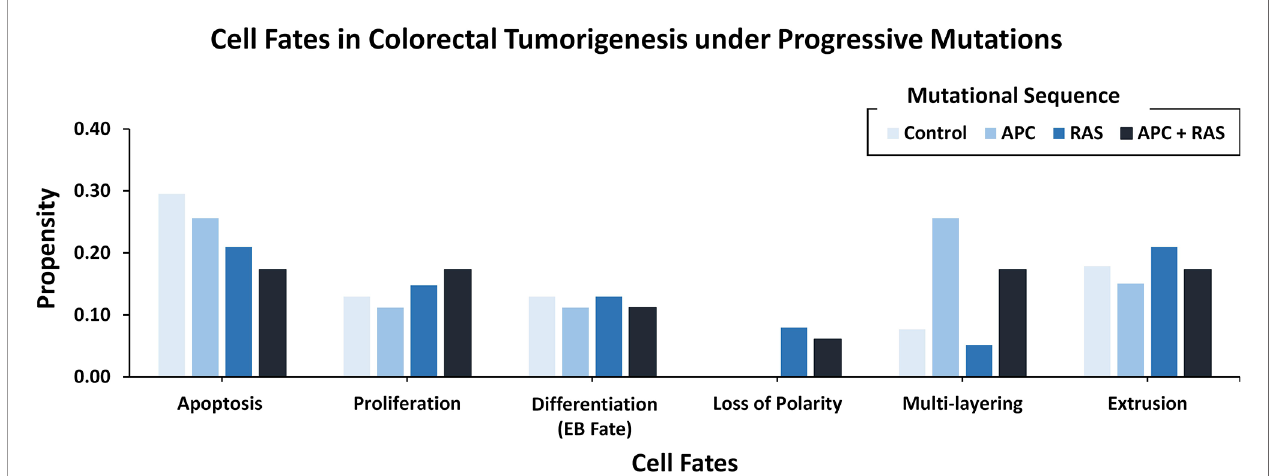
FIGURE 4 | Cell fate outcomes after the introduction of progressive CRC mutations and their validation against Martorell et al. ‘ s Drosophila CRC model. A high rate of extrusion and loss of polarity was observed in Apc-Ras as well as Ras clones. Alongside, an increased proliferation rate with a decreased apoptosis and differentiation is also highlighted by Martorell et al. in their in vivo